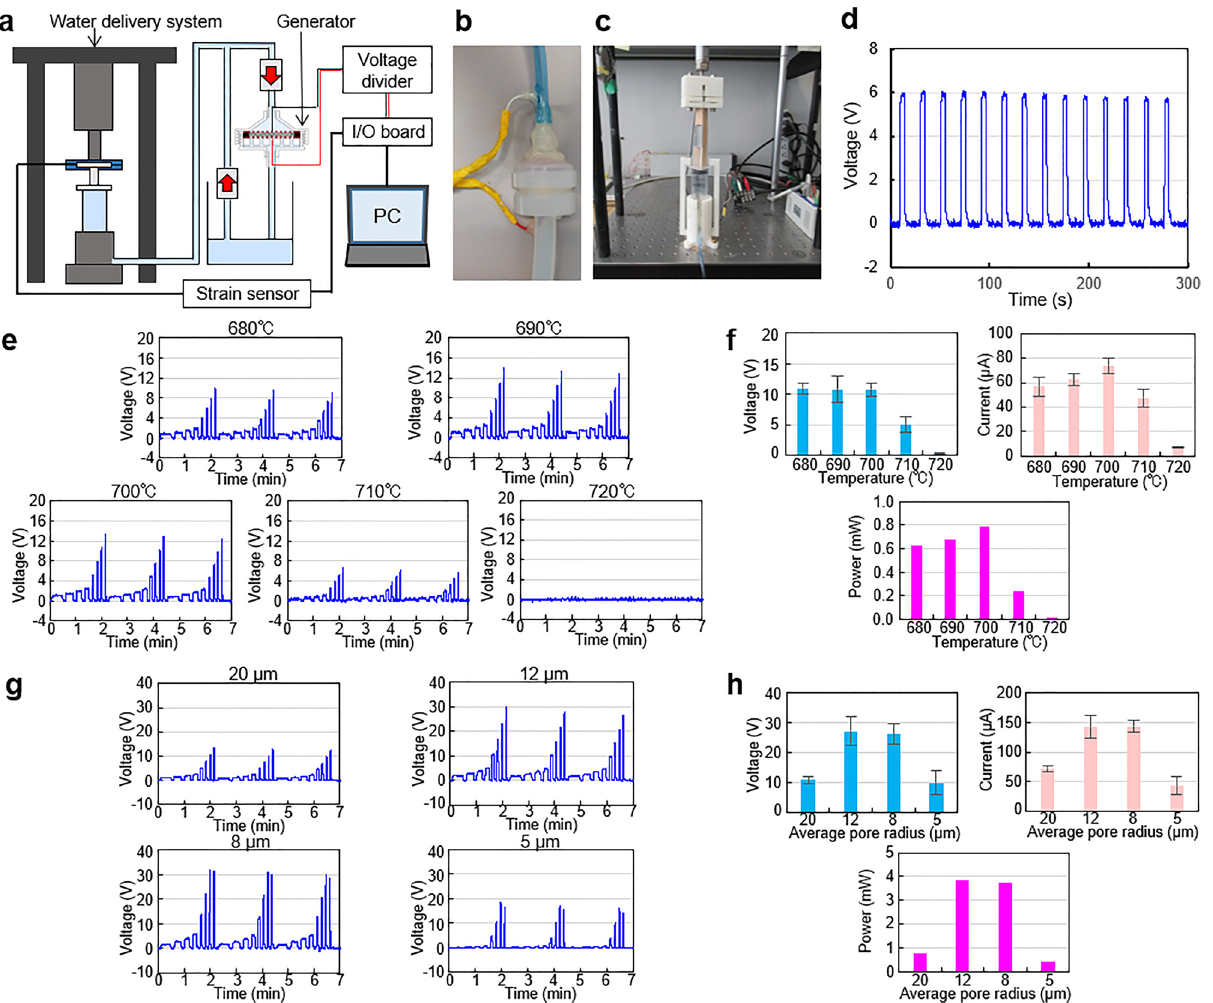
Figure 3. Characterization of power generating performance of fabricated glass filters. ( a ) Setup for characterization of the glass filters. Water is introduced into the generator by the water delivery system and it is circulated using check valves. Measured voltage is recorded by a PC through an I/O board. ( b ) Photo of the generator equipped with the glass filter and electrodes. ( c ) Photo of the water delivery system. ( d ) Voltage time- course of the repetitive power generation using the filter sintered at 700 °C and 5 min glass powder milling time. The water delivery system speed was 20 mm/s. ( e ) Voltage time-courses using the porous glass filters sintered at the temperature indicated at the top of each graph. Each graph shows voltage during 3 pressing cycles at water delivery system speeds of 4, 6, 8, 10, 20, 30, 40 and 50 mm/s. ( f ) Voltage, current and estimated power of the generators versus sintering temperature of the glass filters at the water delivery system speed of 50 mm/s. Voltage and current plots represent average ± S.D. (n = 3). ( g ) Voltage time-courses using the porous glass filters sintered at 700 °C with average pore radius indicated at the top of each graph. Water delivery conditions were the same as in ( e ). ( h ) Voltage, current and estimated power of the generators versus average pore radius. Voltage and current plots represent average ± S.D. (n =